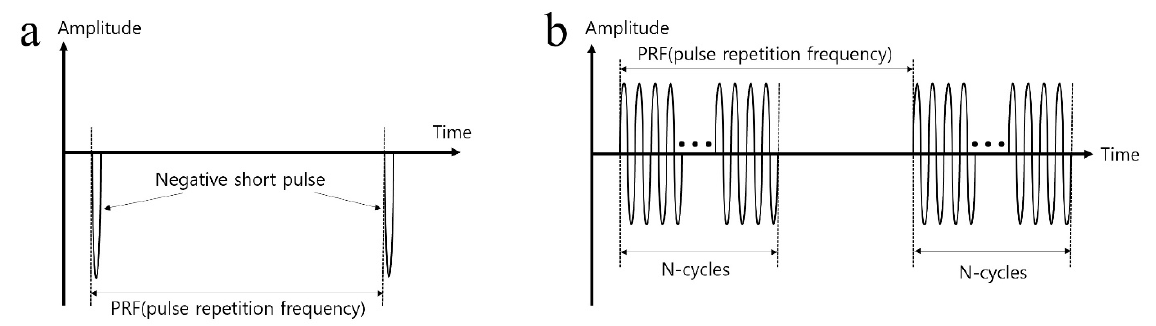
Figure 3. ( a ) Excited negative short pulse waveform for cell-imaging and ( b ) multiple cycles of signal waveform for acoustic tweezer.